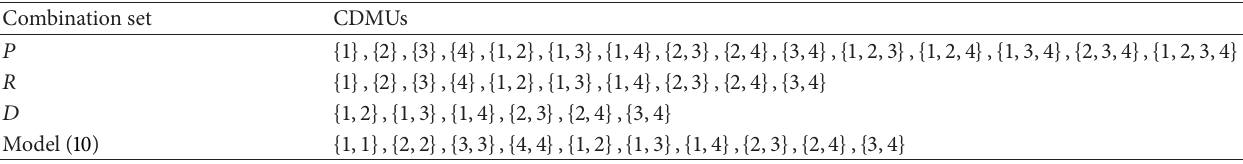
Table 2: Different combinations of DMUs.